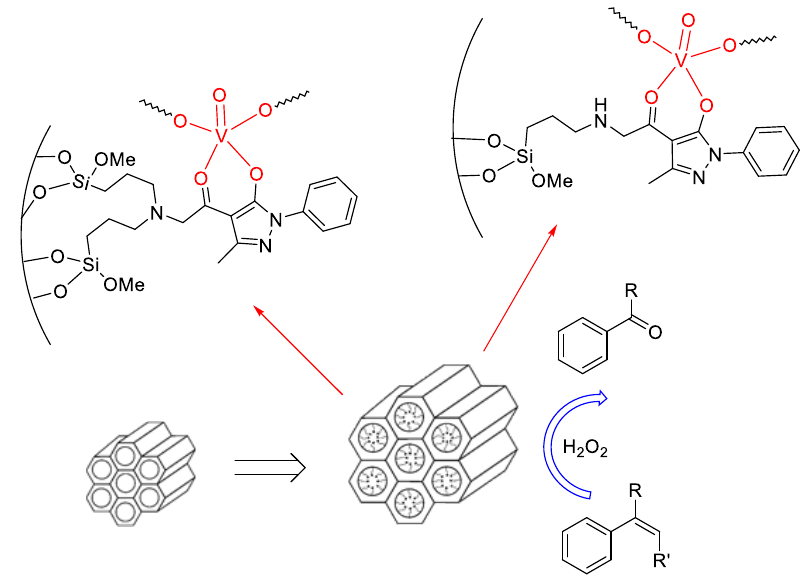
Figure 7. Sketch of the general procedure for the preparation of SBA-15 anchored oxidovanadium based catalysts.